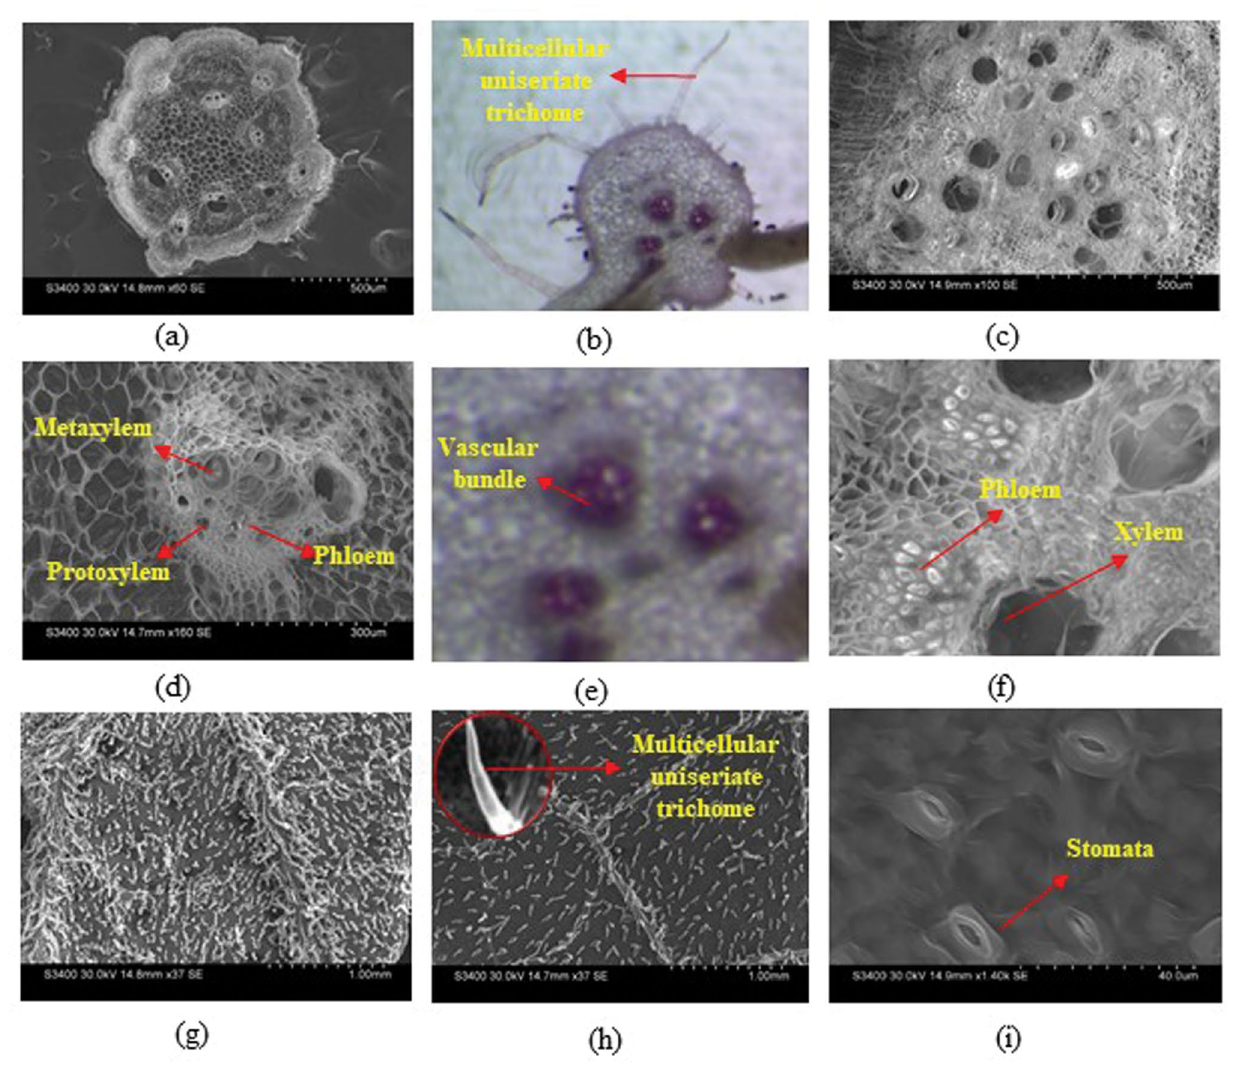
Figure 3. Scanning electron microscopic (SEM) micrographs of transverse sections of stem (a) ; leaf through midrib (b) ; root (c) ; vascular bundle of stem showing metaxylem, protoxylem and phloem (d) ; vascular bundle of leaf (e) ; root section showing xylem and phloem (f) ; lower surface of male leaf (g) ; lower surface of female leaf with magnifying view of trichome (h) ; and stomata on lower epidermis (i)